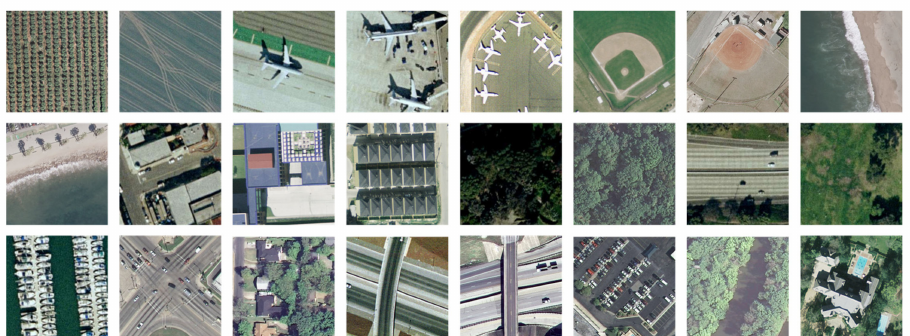
Figure 5. Some samples selected from the UCM captions dataset. The UCM captions dataset contains 21 scenes, such as aircraft, golf courses, farmlands, overpasses, ports, etc. The size of each remote sensing sample is 256 × 256, and the format is TIFF.